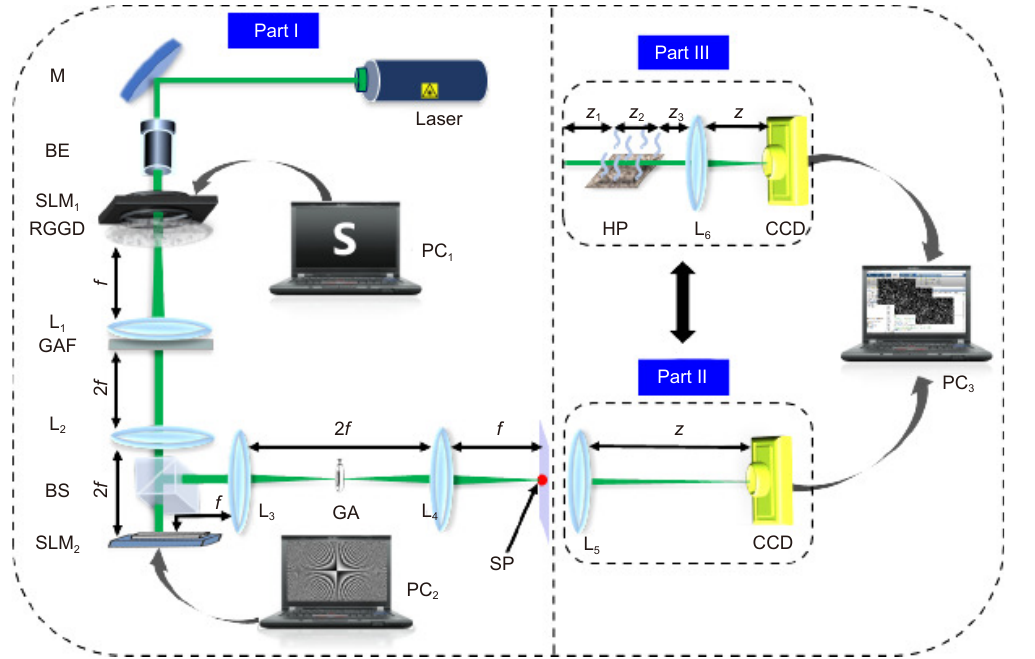
Fig. 3 | Schematic diagram of the experiment setup for generation of Schell-model beams with a controllable CP structure, measure- ment of the modulus of the DOC in the far field propagation in free space as well as in turbulent atmosphere . Laser, a Nd:YAG laser with wavelength 532nm; M, mirror; BE, beam expander; SLM 1 , SLM 2 , spatial light modulator; RGGD, rotating ground glass disk; L 1 , L 2 , L 3 , L 4 , L 5 , L 6 , thin lenses with the identical focal length f =250mm; GAF, Gaussian amplitude filter; BS, beam splitter; CA, circular aperture; SP, source plane; CCD, charge-coupled device; HP, hot plate; PC 1 , PC 2 , PC 3 , personal